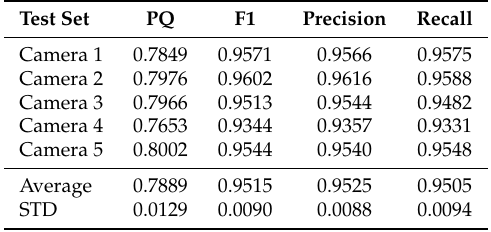
Table 6. Results for a five-fold cross-validation on the data set: In each row, one of the cameras was declared as the test set, and the images from the four remaining cameras were use for training and